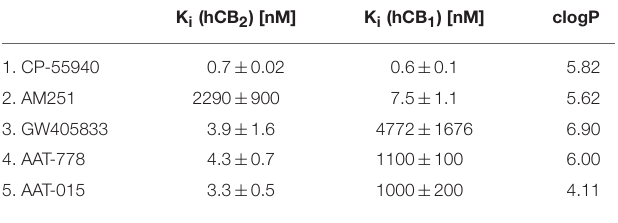
TABLE 1 | K i -values of known CB 1 /CB 2 ligands (entry 1–3; Showalter et al., 1996; Lan et al., 1999; Valenzano et al., 2005) and newly synthesized compounds (entry 4,